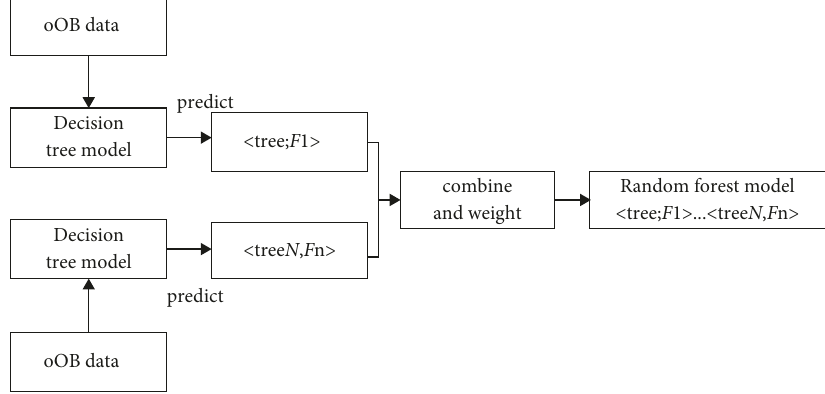
Figure 2: Weighting